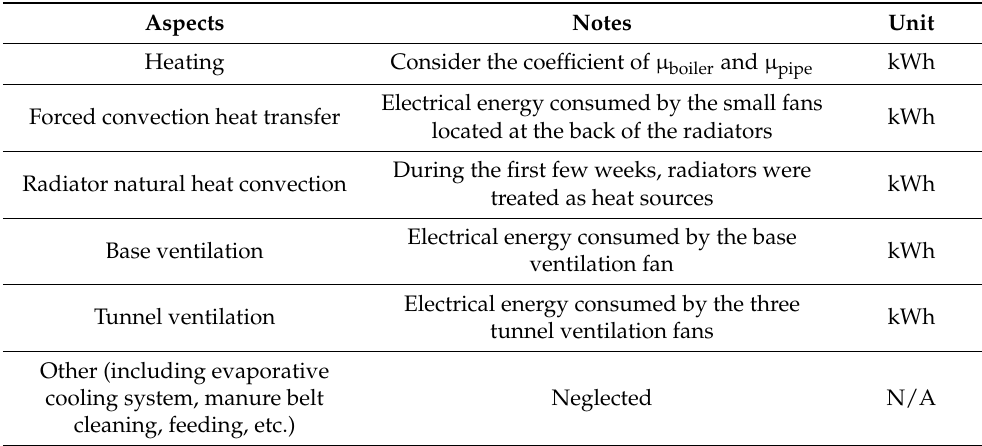
Table 5. Aspects considered in the model for the final energy consumption